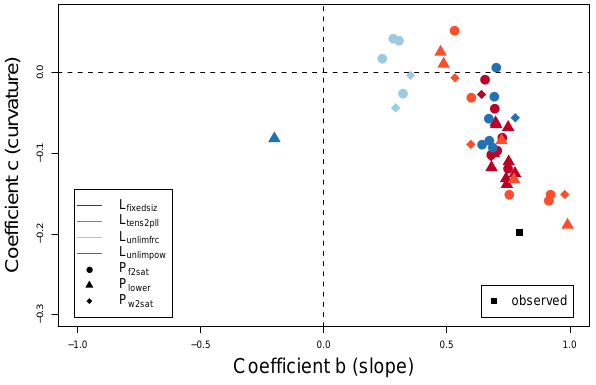
Fig. 6. Relation between b and c coefficients of the polynomial function fitted to binned recession